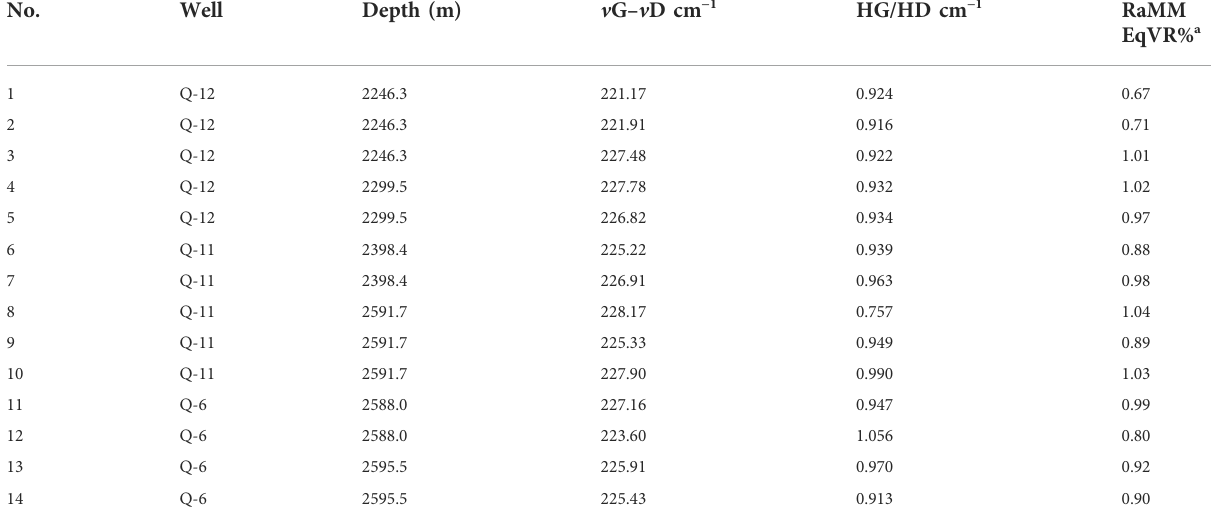
TABLE 5 Raman spectral parameters of vitrinite from Dongpu Sag